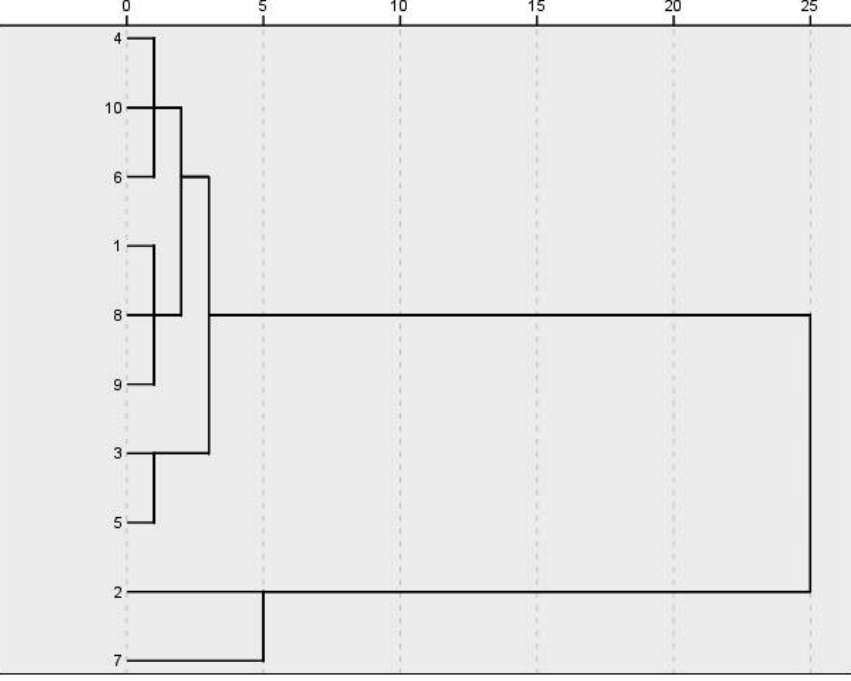
Figura 1 . Dendrograma de aglomerados segundo o desempenho nos subtestes da Prova de Consciência Sintática – Adaptada.